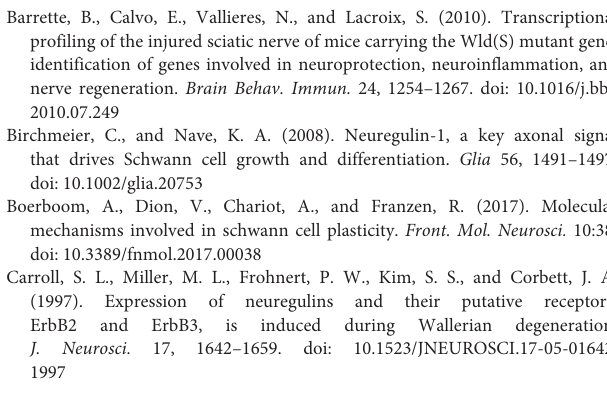
TABLE S1 | Differential expression analysis. Sheet 1: deseq2 results for all genes; Sheets 2 and 3: up- and down-regulated genes (adjusted P < 0.05 and fold-change >2 or < 0.5). TABLE S2 | The complete list of enriched categories of Biological Processes (BP), Molecular Functions (MF) and Cellular Components (CC) obtained by Gene Ontology enrichment analysis of regulated